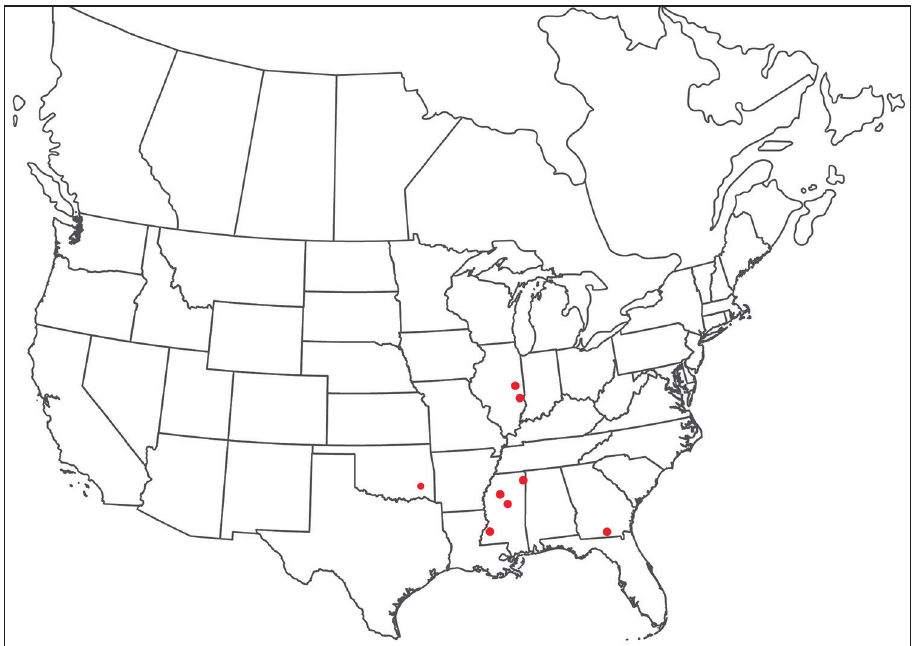
Figure 87. Torrenticola gnoma sp. n.